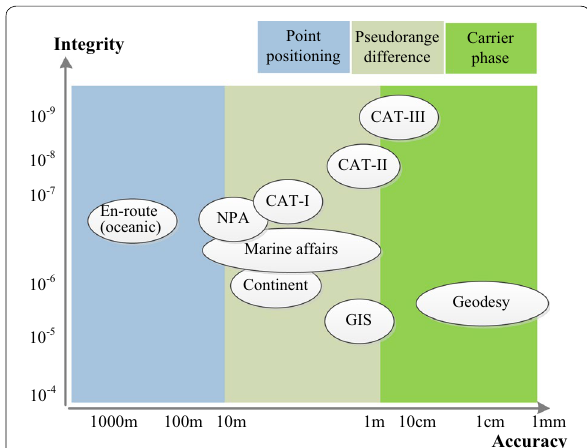
Fig. 1 Performance requirements in terms of accuracy and integrity